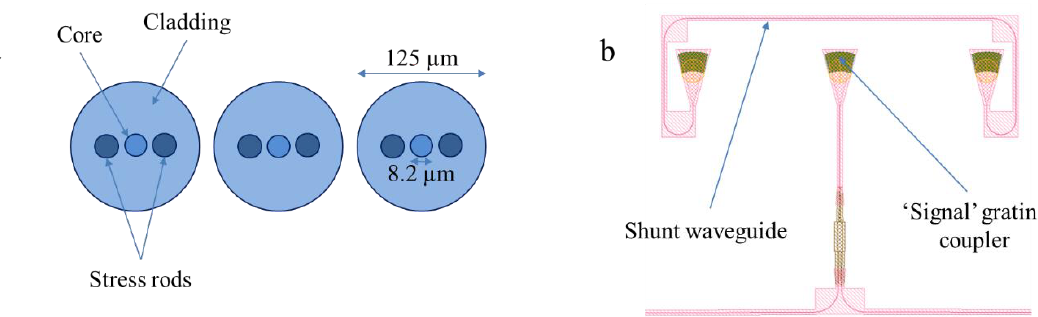
Figure 3. ( a ) Polarization maintaining fibre array with stress rods oriented to deliver transverse-electric (TE) mode on the grating couplers. ( b ) Shunt waveguide connecting two dummy grating couplers for active fibre coupling